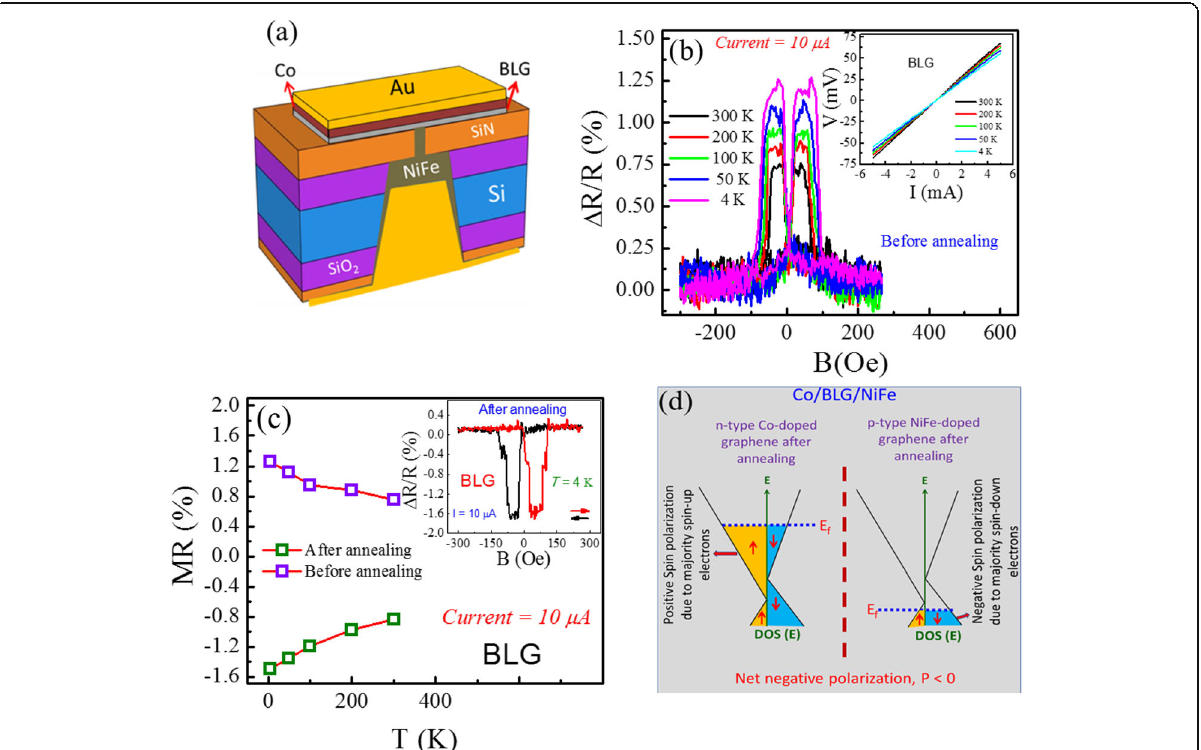
Fig. 1 a Scheme of device fabrication where ferromagnetic Co and NiFe metals were deposited on the top and bottom, respectively. b The change in R vs B traces before annealing at different temperatures (with I = 10 μ A). (Inset) Current-voltage characteristics of the BLG at different temperatures are linear and indicate an ohmic contact. c Temperature-dependent MR values of the BLG before and after annealing at fixed ac current. (Inset) The MR vs B of Co/BLG/NiFe junction after annealing at T = 4K. d Schematic drawing of spin-dependent density of states for BLG. Band splitting gives a difference in spin-up and spin-down carriers at E F . The thick dashed red line in the middle shows decoupling of van der Waals-bonded